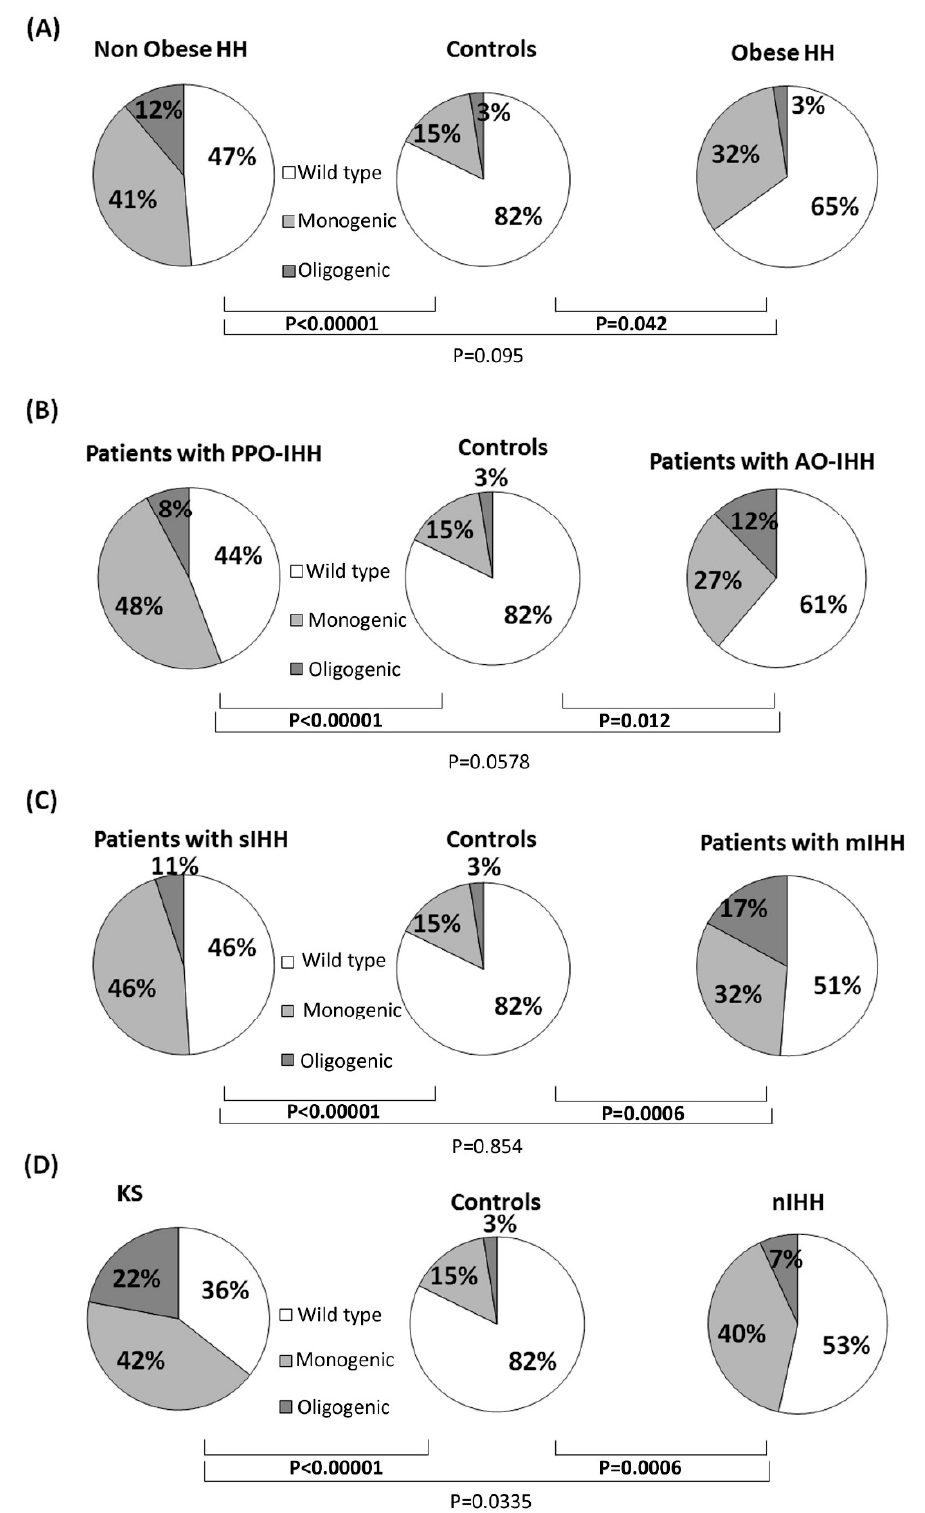
Figure 1. Frequency of rare genetic variants in 28 IHH candidate genes among the different groups of patients and controls. Comparisons of rare allelic variants prevalence according to the presence of obesity ( A ), age of IHH onset ( B ), TTe levels ( C ) and olfactory defects ( D ). “Rare variants” includes all single variants, either those presenting as monogenic or those associated with other variants in an oligogenic pattern.